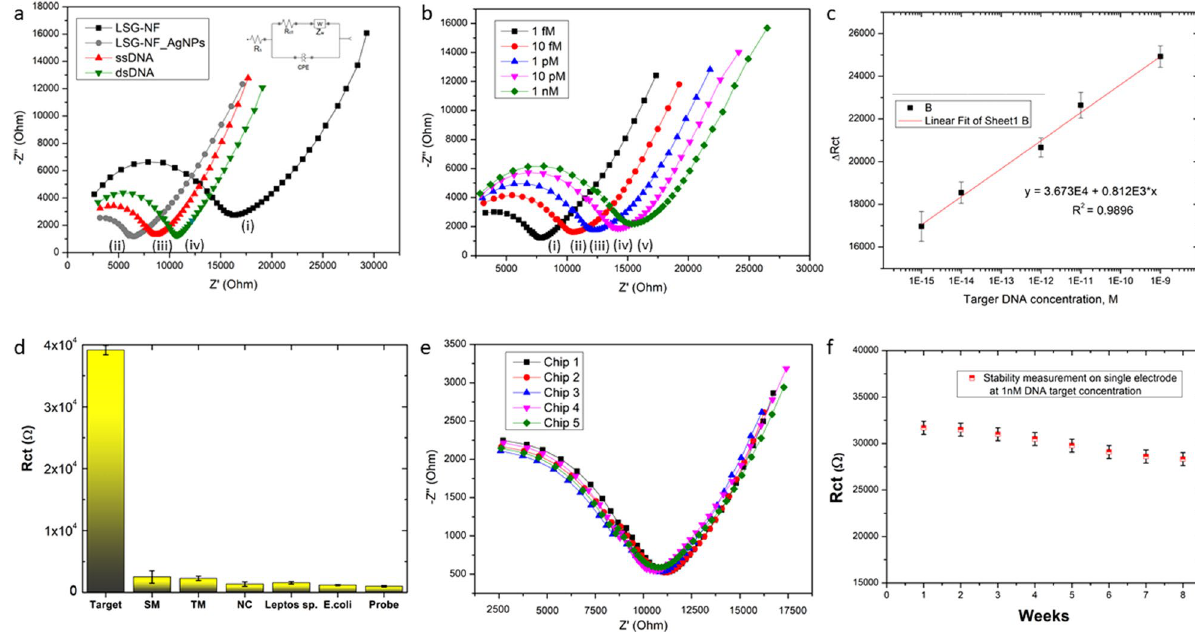
Figure 5. ( a ) Impedimetric curve of (i) LSG-NF, (ii) LSG-NF-AgNP, (ii) immobilized LSG-NF-AgNPs (probe), and (iii) hybridized LSG-NF-AgNPs (duplex) bioelectrode; the inset shows the Randles equivalent circuit, where the parameters R s , R ct , Z w , and CPE represent the bulk solution resistance, charge transfer resistance, Warburg impedance, and constant phase element respectively. ( b ) Impedance spectra of LSG-NF-AgNPs hybridized with different concentrations of complementary target DNA (i–v) 1 fM to 1 nM, ( c ) illustrates the linear regression curve at different concentrations of target DNA with the linear equation: ΔR ct = 0.812 × 10 3 x + 3.673 × 10 4 , ( R 2 = 0.9896), ( d ) bar chart showing specificity of the LSG-NF-AgNP bioelectrode against